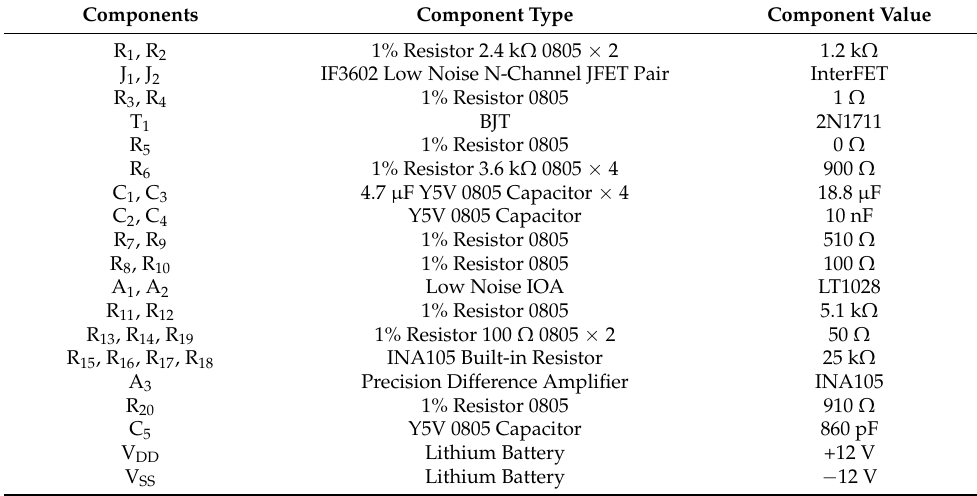
Table 2. Circuit device